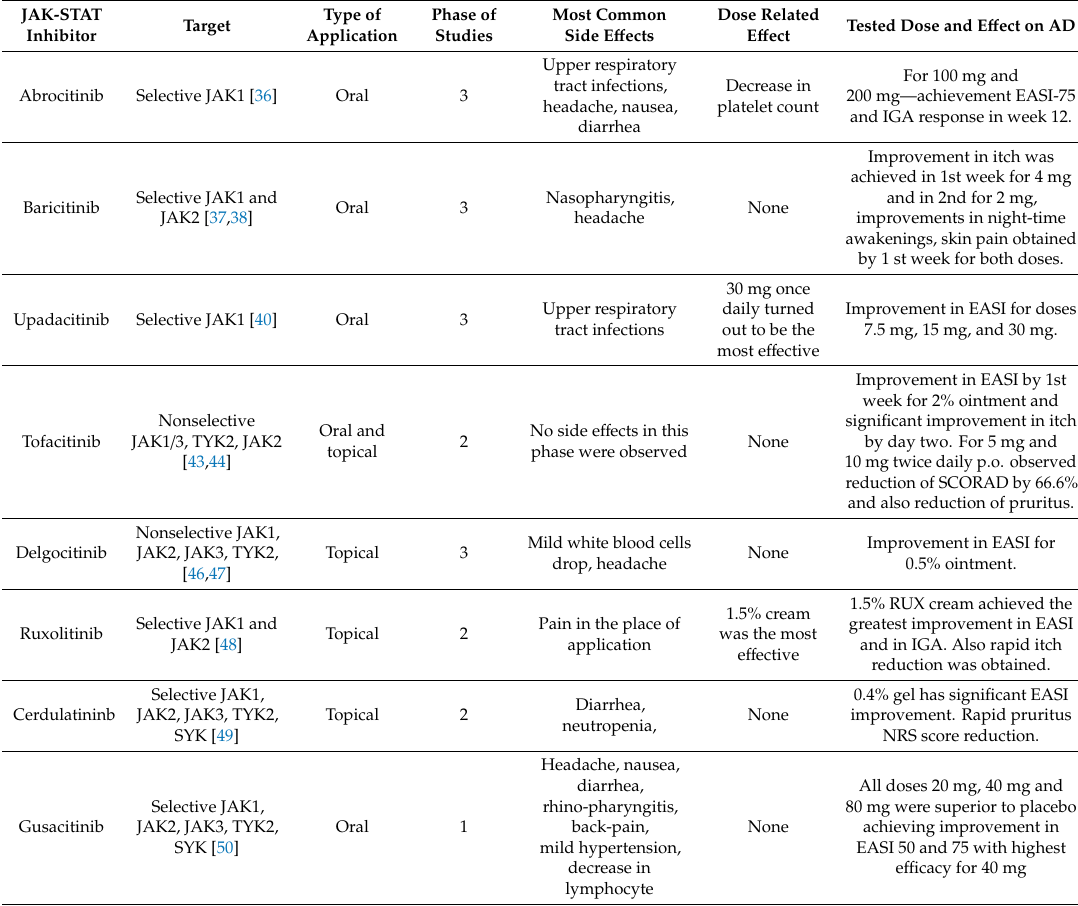
Table 1. Comparison of JAK STAT